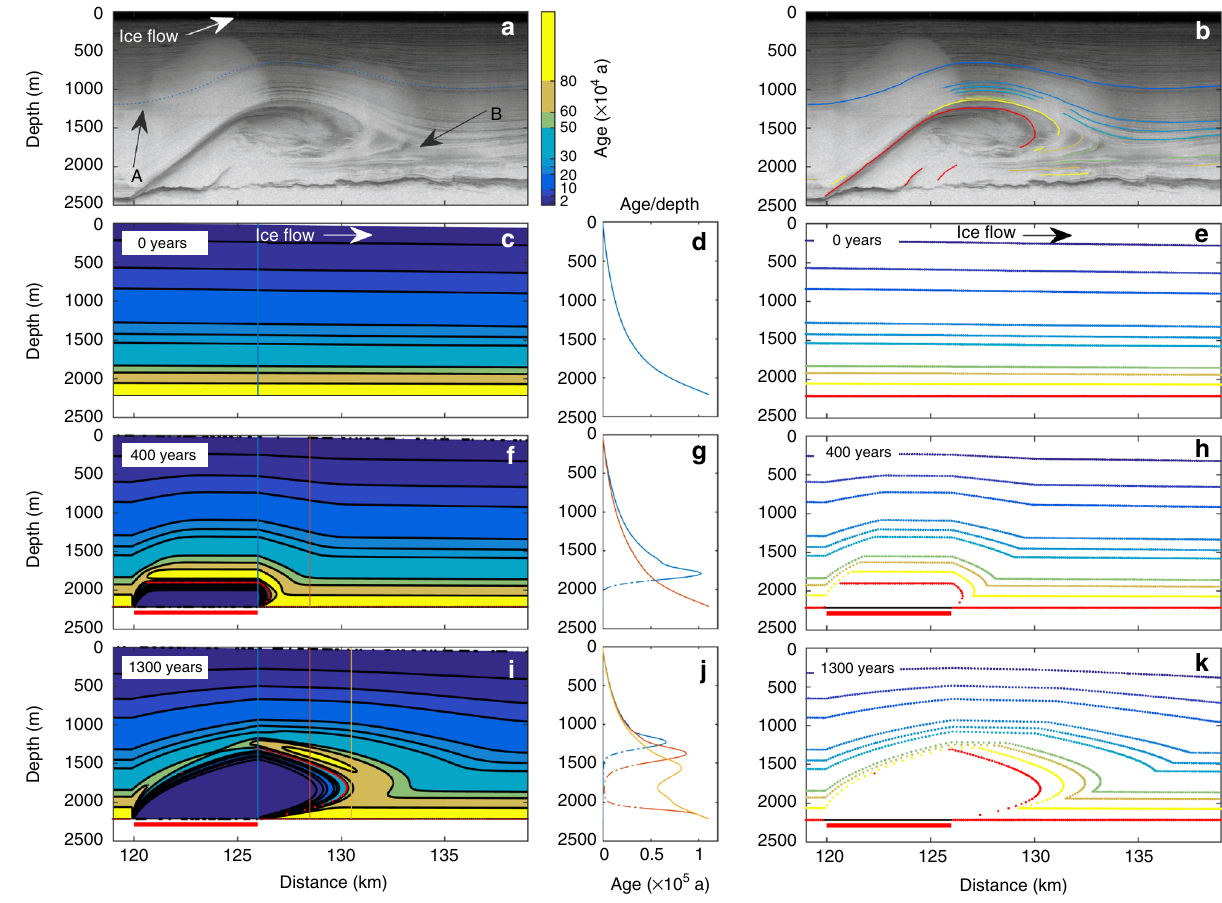
Fig. 3 Observed and modelled plume showing internal layering. a RES pro fi le (20120507_07_001,002) 4 of a plume-like feature (magenta- fi lled triangle in Fig. 2) ≈ 25° oblique to fl ow (see Supplementary Fig. 5), showing characteristic internal layering with upward bending (arrow A) and downstream folding (arrow B). b Same RES pro fi le with interpretation of meteoric layers (solid lines; colour legend for age as for modelled layers) and outlined freeze-on plume (red solid line). c Modelled internal layer structure purely by internal deformation for a surface-accumulation rate _ a ¼ 0 : 1 ma (cid:2) 1 , zero accretion and a surface-slope α s = 0.003. Age contours (at 0, 2, 6, 10, 20, 25, 30, … , 80 × 10 4 years) matching inferred layers (right margin in b ). d Undisturbed age-depth pro fi le (blue line in c ). e Particles (coloured dots) taken along age contours in c . f , i Modelled internal layer structure 400 and 1300 years after switch on of freeze-on, respectively, with freeze-on rate _ f ¼ 0 : 8 ma (cid:2) 1 over 6 km accretion area (red horizontal bar). Tracked interface between meteoric and accreted ice (red dots from h and k , respectively). g Disturbed and undisturbed age-depth pro fi le for vertical lines in f , above (blue line) and in front (red line) of the accretion area, respectively. h , k Particles tracked over time using modelled velocity fi eld (from f and i , respectively) showing the layer architecture in detail, as it is not affected by diffusion. Interface between meteoric and accreted ice (red dots). j Disturbed age-depth pro fi les above (blue line) and in front of the accretion area (red and orange lines). Note, age-depth pro fi le representing accreted ice (dashed-dotted line) and age diffusion in the vicinity of